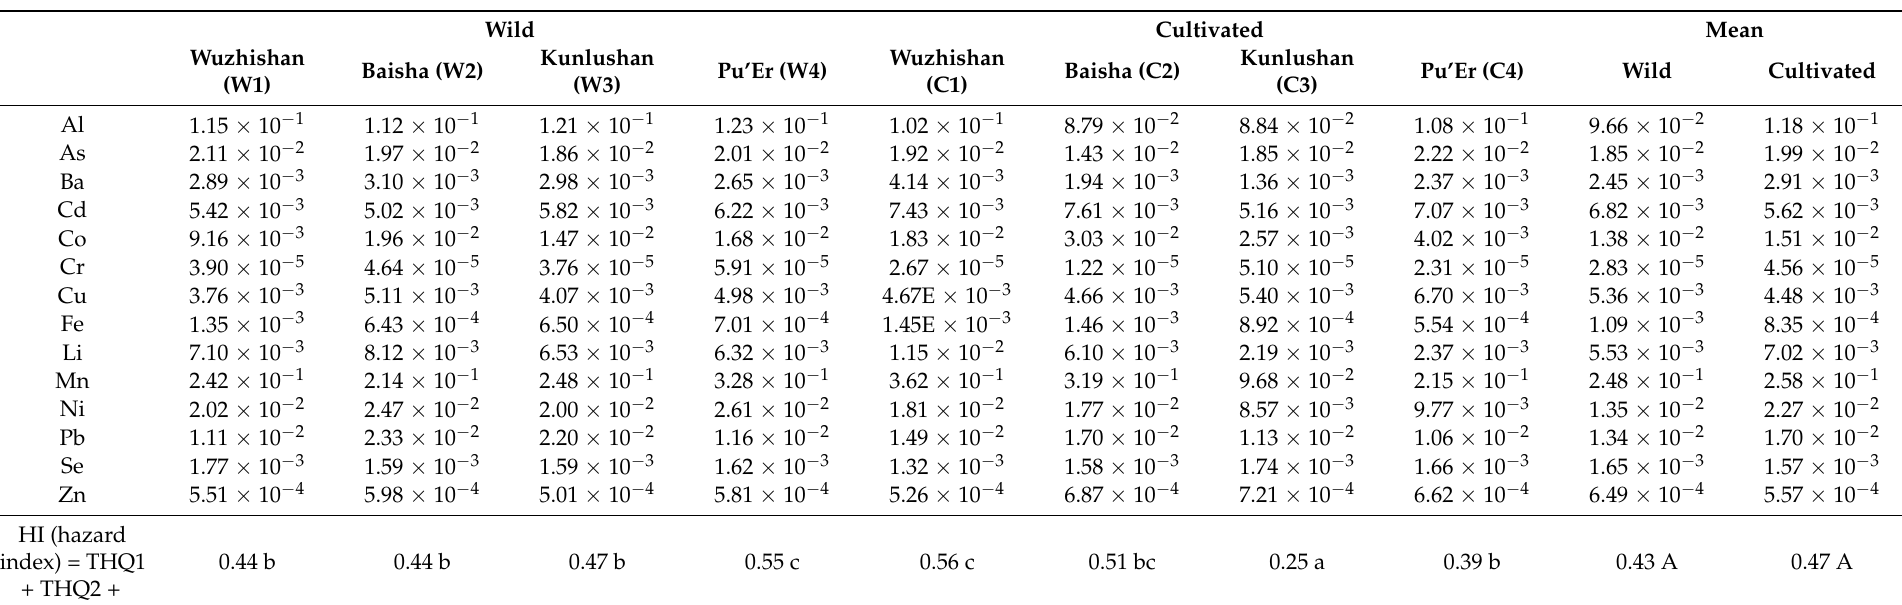
Table 6. The calculated target hazard quotients (THQs) of microelements and the accumulative hazard indices (HI) for adults associated with the consumption of infusions of tea.